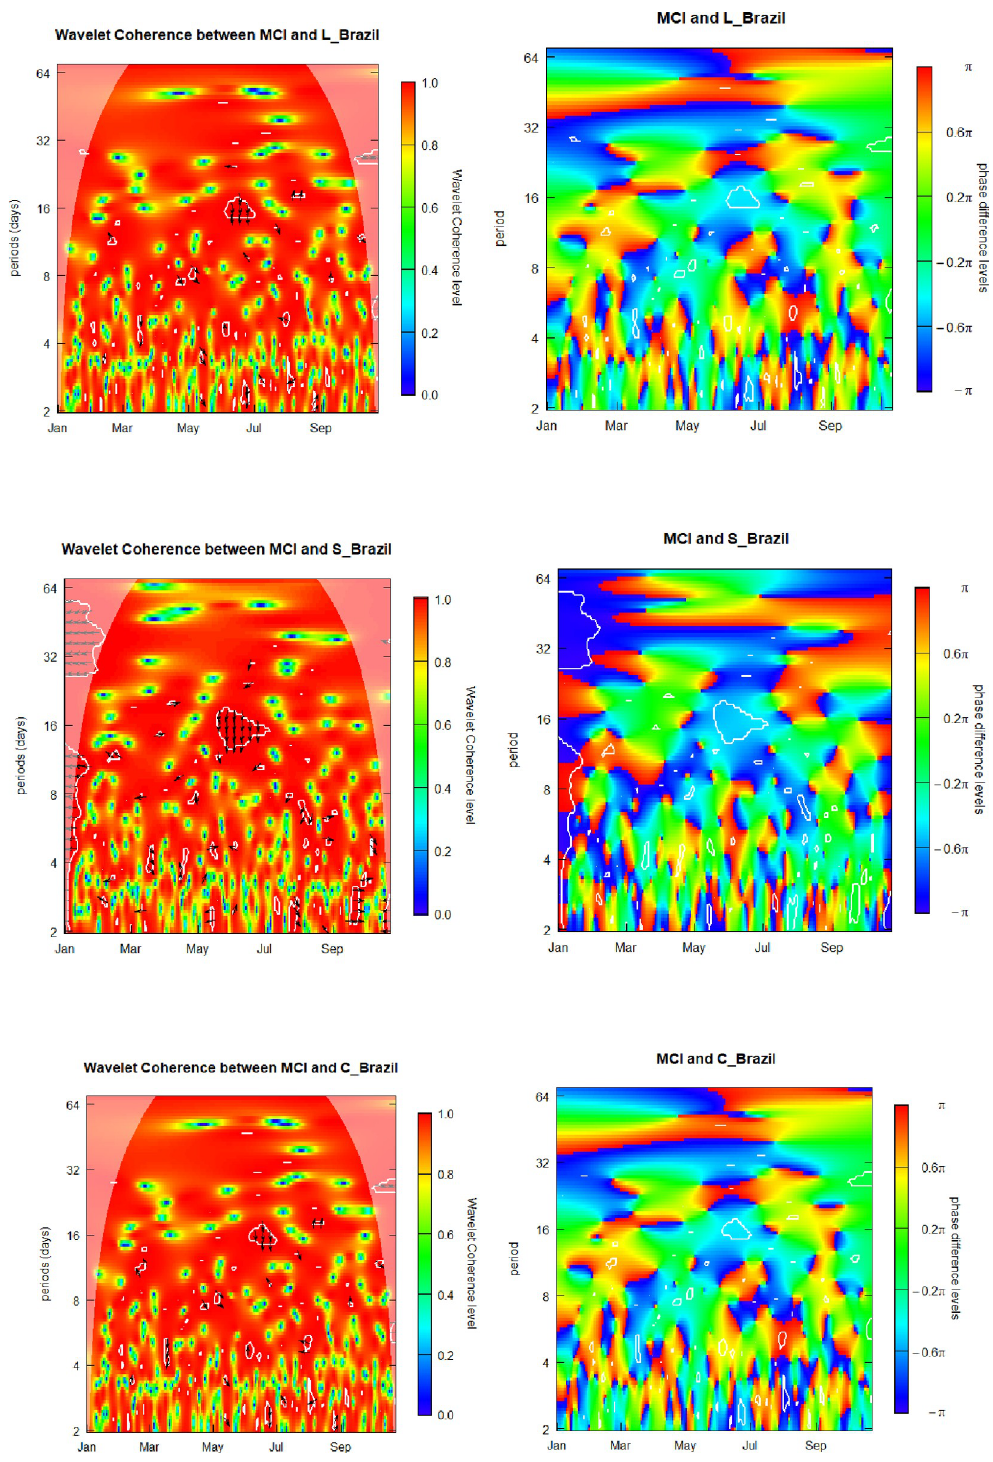
Fig 1. Media Coverage Index (MCI) and sovereign yield components of Brazil. L_Brazil, S_Brazil, and C_Brazil denote the level, curvature and slope component for Brazil.